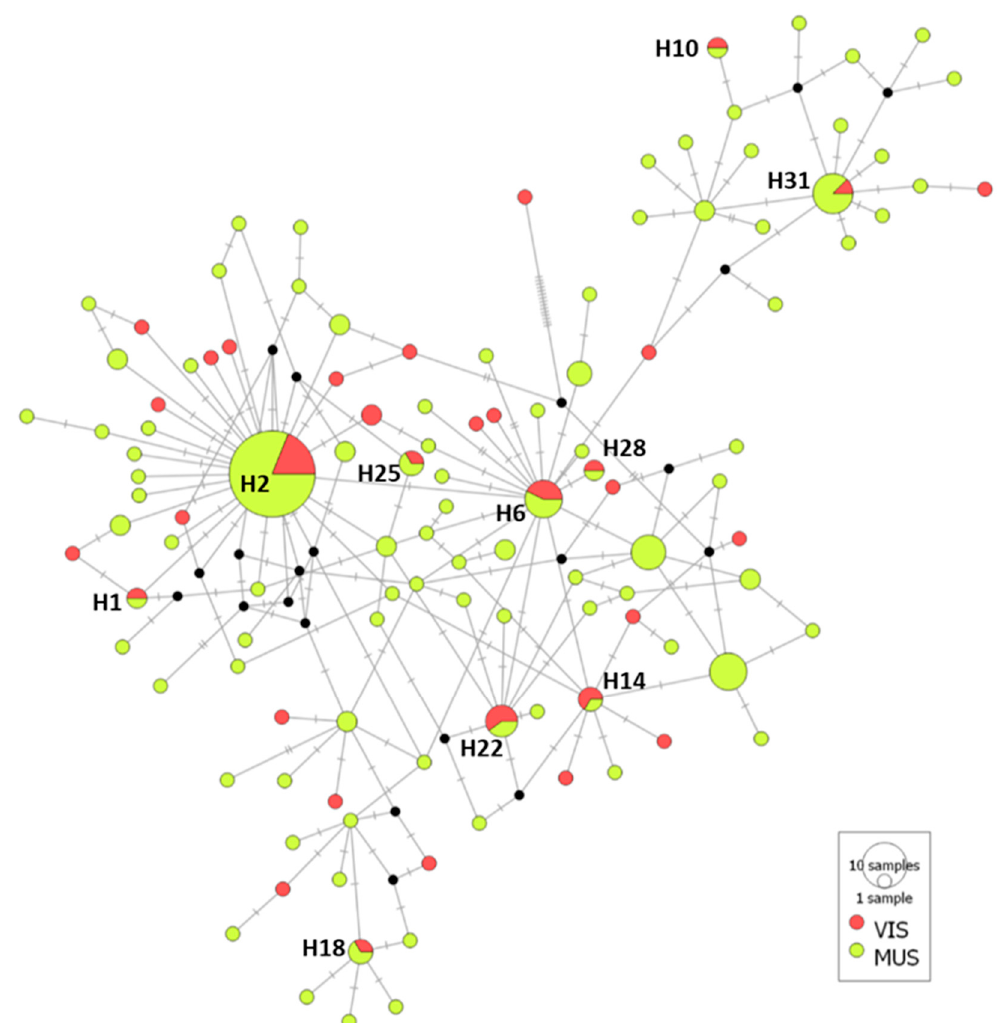
Figure 4. Median-joining haplotype network of A. simplex mtDNA cox2 sequences obtained from viscera (VI) and muscle (MUS) of European hake. Circles’ size represents the frequency of each haplotype. Hatch marks show the number of mutations distinguishing the haplotypes. Haplotypes shared for VIS and MUS are reported. Black points indicate missing haplotypes.